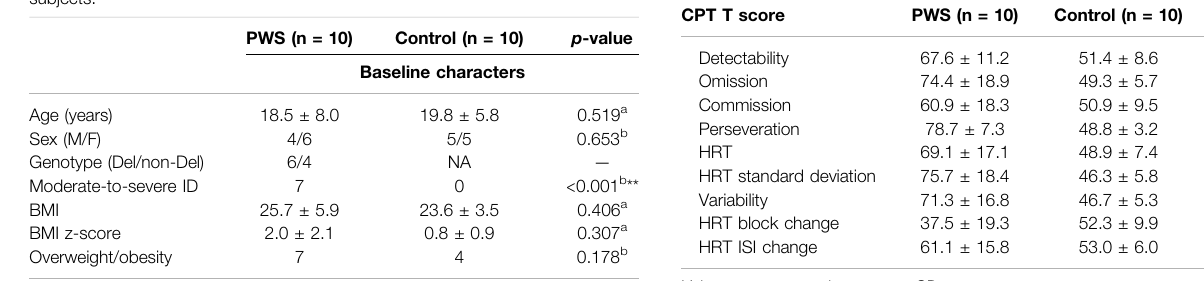
TABLE 2 | Conner ’ s CPT scores of patients with PWS and control